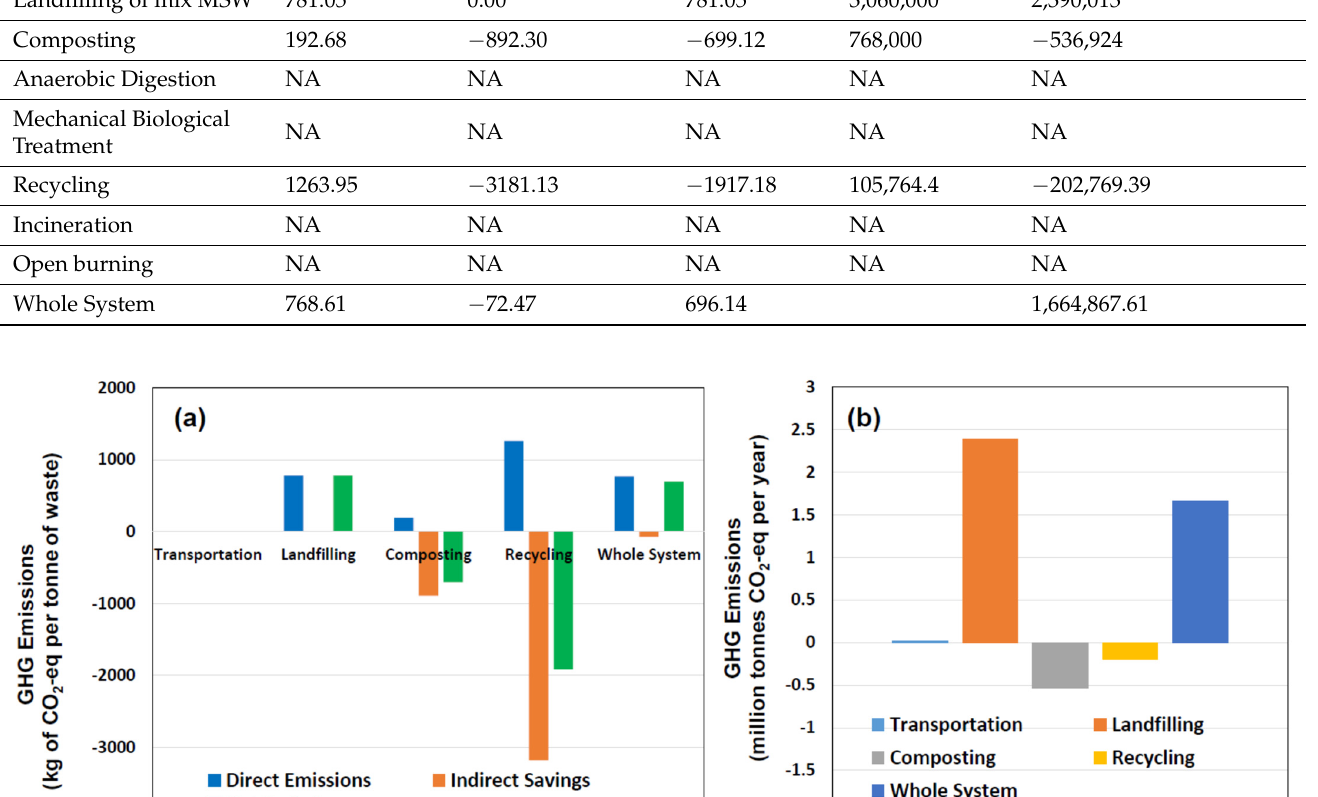
Figure 5. Estimates of GHG emissions from the MSW management of Ho Chi Minh City ( a ) GHG estimates include direct emissions, indirect emission saving (or avoiding), and net emissions from various solid waste mismanagement practices including the whole solid waste management system (expressed in kg CO 2 -eq. per tonne of waste managed); ( b ) net yearly emissions of GHG from the whole MSW management system (expressed in million tonnes/year).